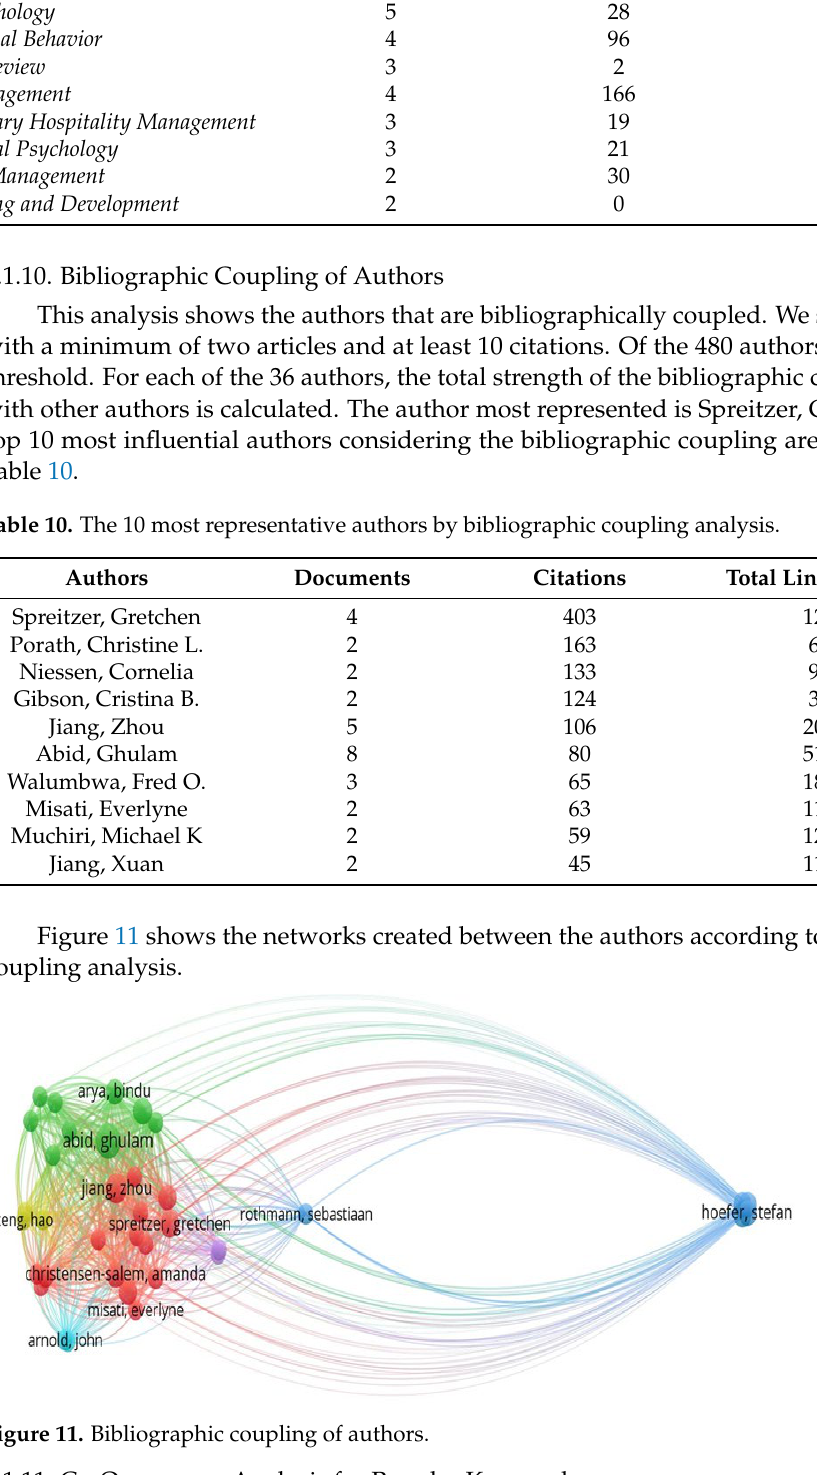
Table 11. The most popular keywords in the topic of thriving at work. Keyword